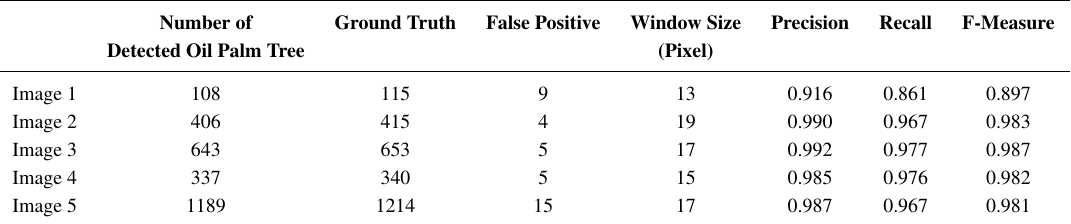
Table 4. Performance evaluation of the proposed method using WorldView-2 imagery. Number of Ground Truth False Positive Window Size Precision Recall F-Measure Detected Oil Palm Tree